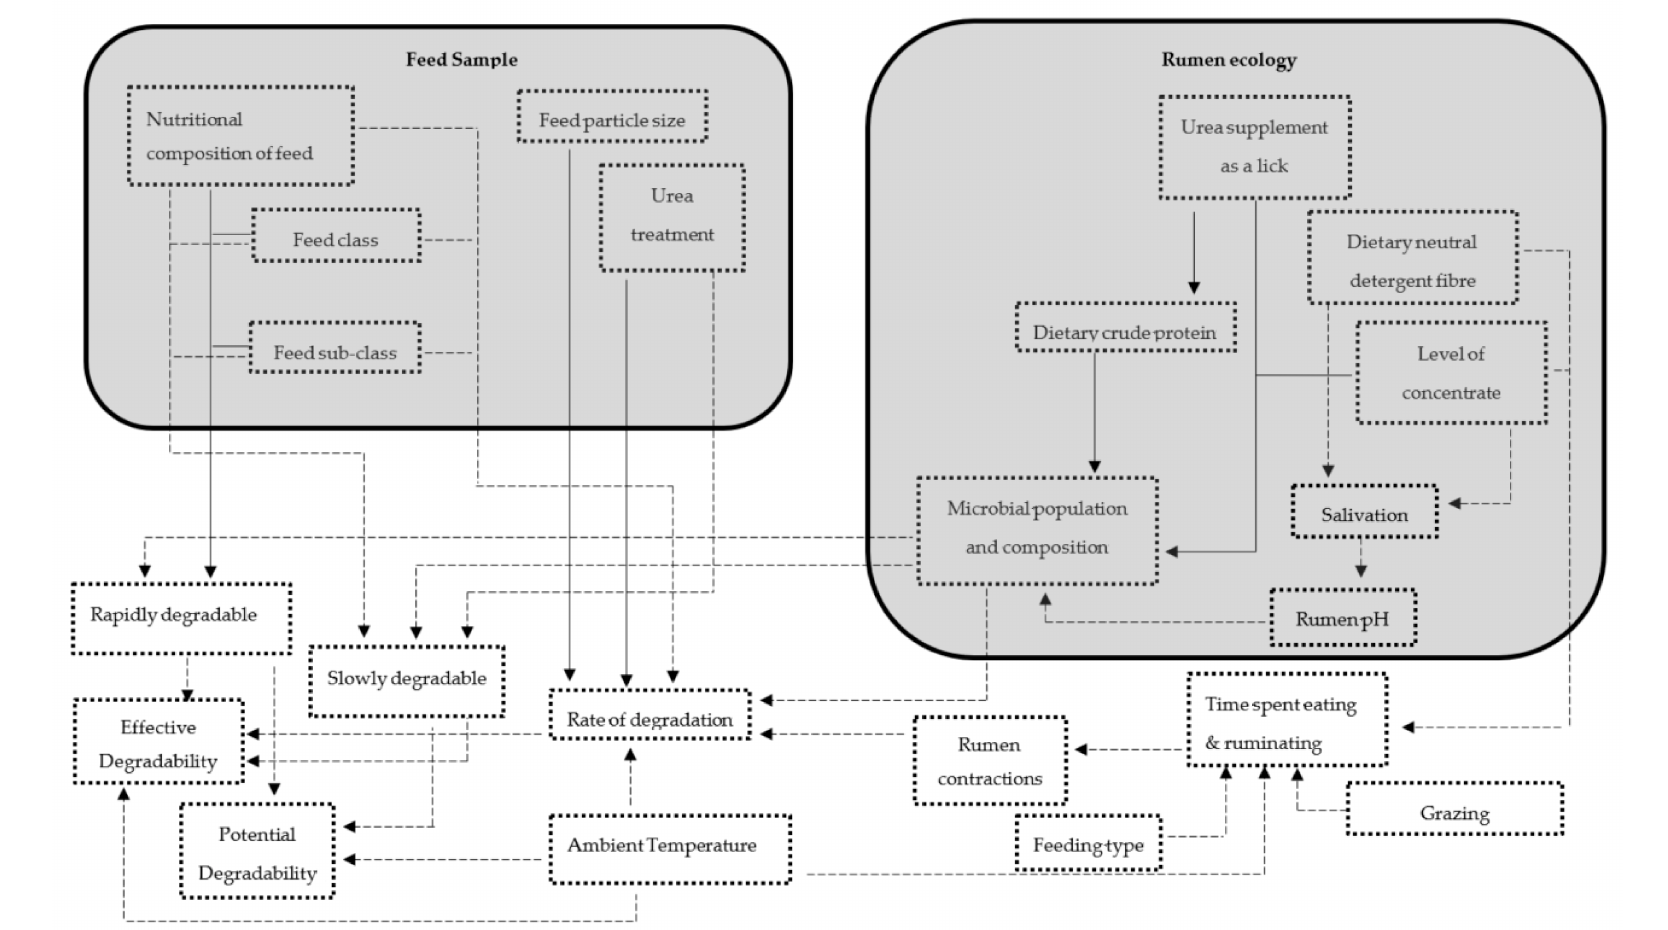
Figure 1. Factors affecting degradation of feeds in the